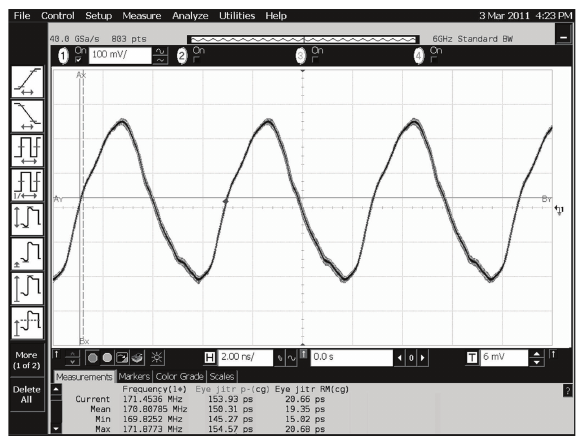
Figure 18: Measured results of interpolated flying-adder output at 33MHz with P k - P k = 435 . 6 ps (multiphase ADPLL at 42.7